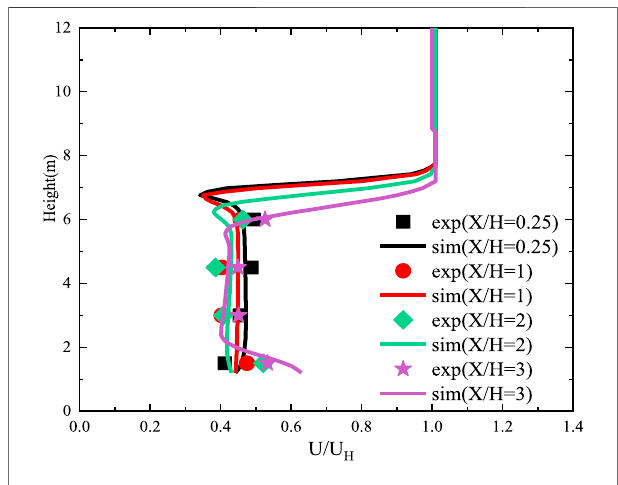
U EXP is the wind speed value measured in the experiment; U SIM is the wind speed value simulated by CFD model; X is the horizontal distance between the monitoring point and the tree; and H TREE is the tree height.